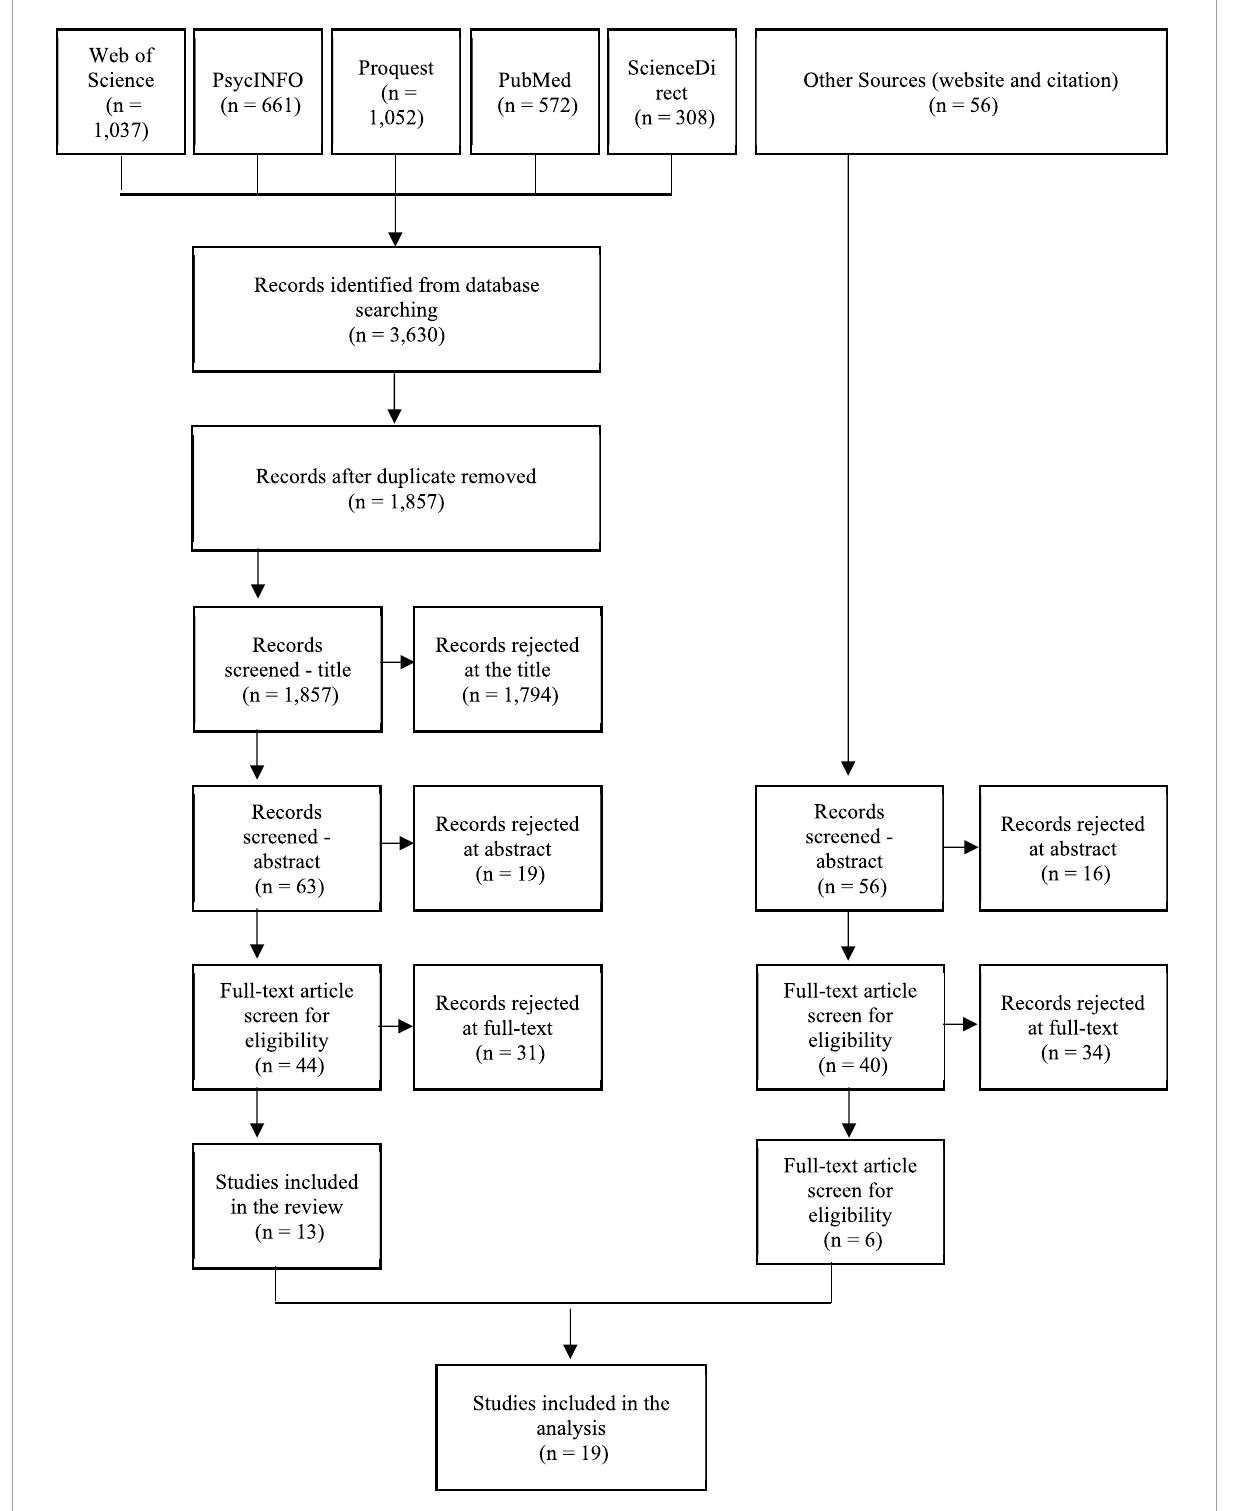
FIGURE2 The PRISMA flow diagram of searched, screened, and included